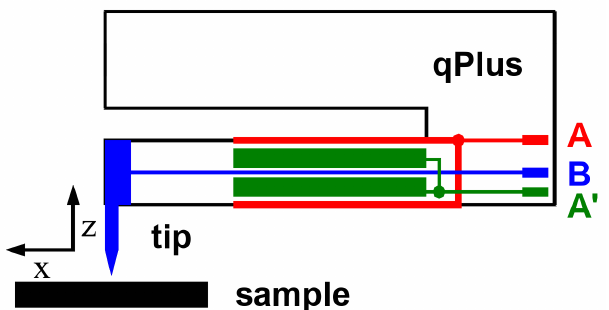
Figure 3. Schematic view of a qPlus force sensor with a tip mounted to it. The qPlus sensor is a cantilever made of a piezoelectric material (typically quartz). Originally, it was built from a quartz tuning fork taken from a Swatch electronic watch [27], but modern versions [29] have little in common with tuning forks and look as shown in the figure. The piezoelectric effect generates opposite electric charges at terminals A and A (cid:48) when the beam is deflected, yielding an ac-current when the beam oscillates. If a metallic tip is used, STM and AFM can be performed in parallel and electrode B connects to a tunneling current amplifier. For detailed explanations and photographs of these sensors, see section III and Figures 9–13 in